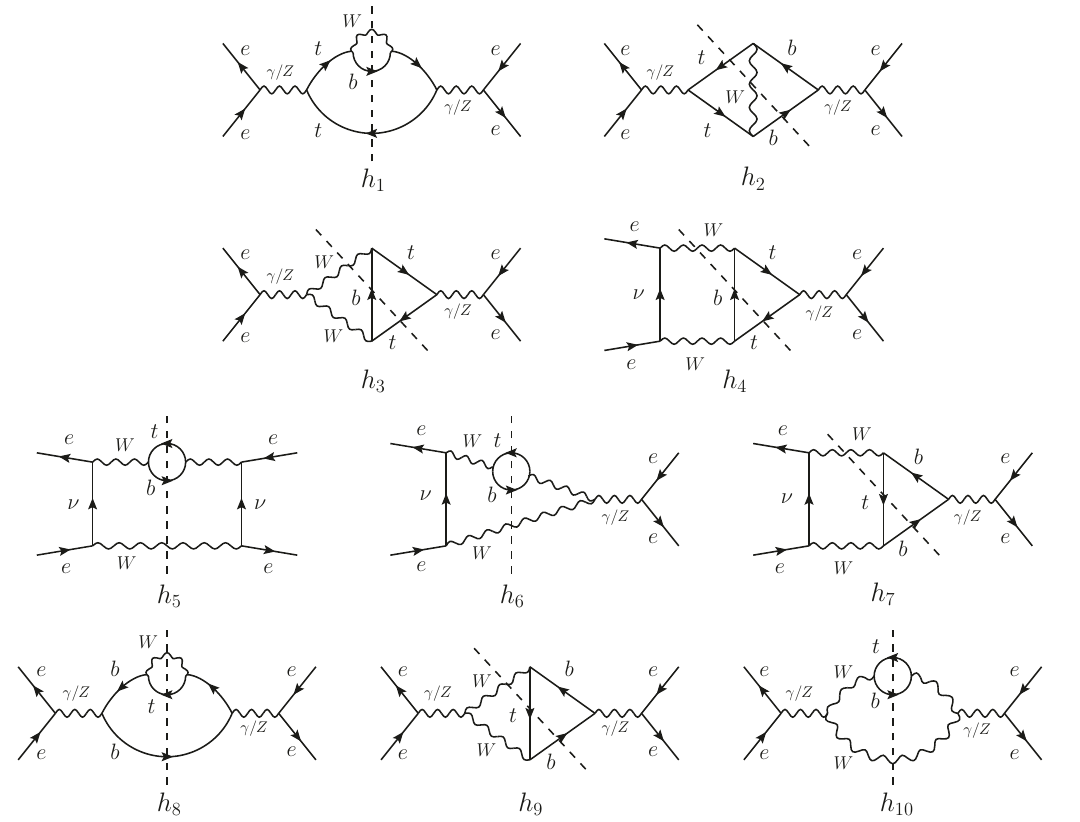
Figure 1 . NLO non-resonant diagrams. Symmetric diagrams and diagrams with tW (cid:0) (cid:22) b cuts are not